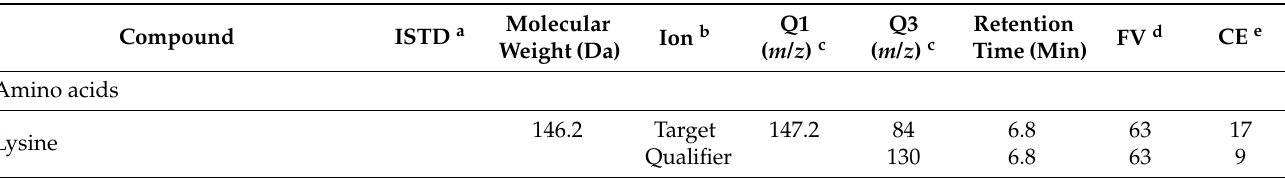
Table 3. Parameters used in the acquisition method to quantify Maillard reaction products and DHA-mediated